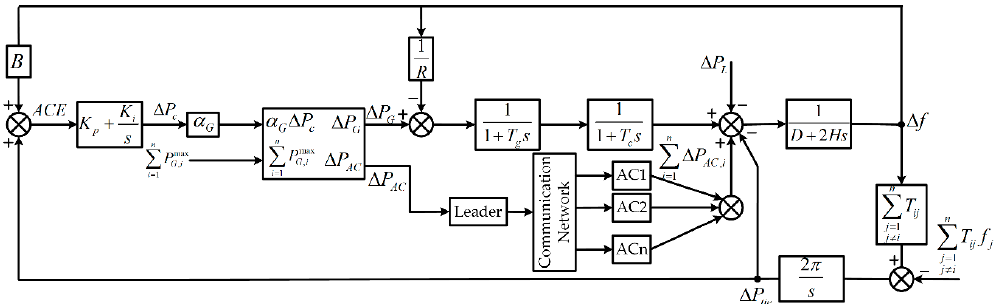
Figure 3. The structure of a single-area system. Table 1. The parameters of a two-area power system.